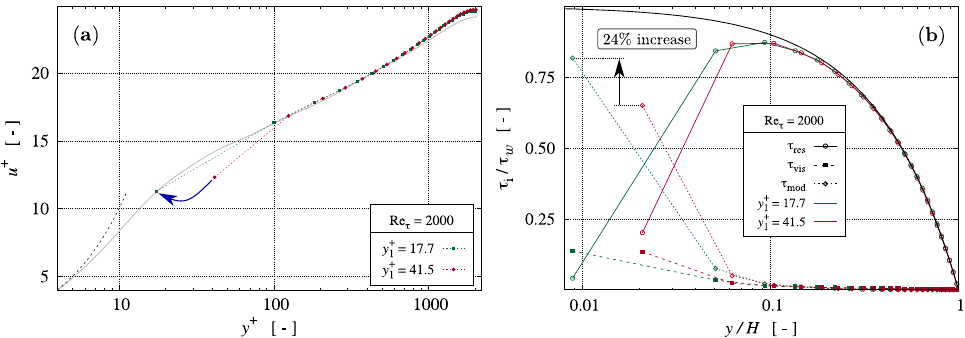
Figure 6. ( a ) Non-dimensional mean velocity profiles for Re τ = 2000 on a grid featuring N H = 24 and ∆ x + = 83. The red velocity graph coincides with the red graph in Figure 1a and refers to the ( ∆ x + ) = 0.5 ∆ x + (cid:54) = y + ( ∆ x + ,Re τ ) . The green curve depicts results standard grid layout with y + 1 1 ( ∆ x + ,Re τ ) = 0.15 ∆ x + ( 1 + 35/ ∆ x + ) manipulation, cf. Equation (10). ( b ) The from the suggested y + 1 overshoot vanishes when the modeled shear stress increases due to an increase in the eddy viscosity, as displayed by the normalized (averaged) τ i partition